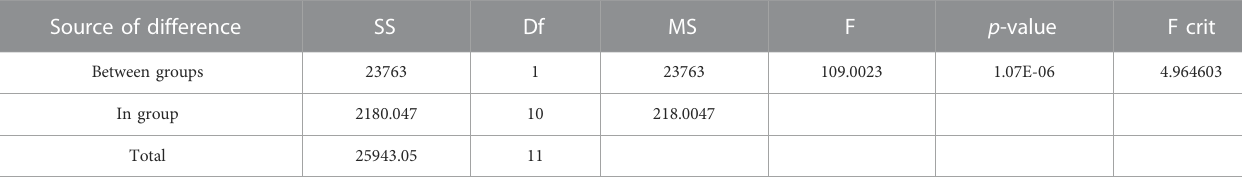
TABLE 14 Variance analysis of ultrasonic frequency effect on point